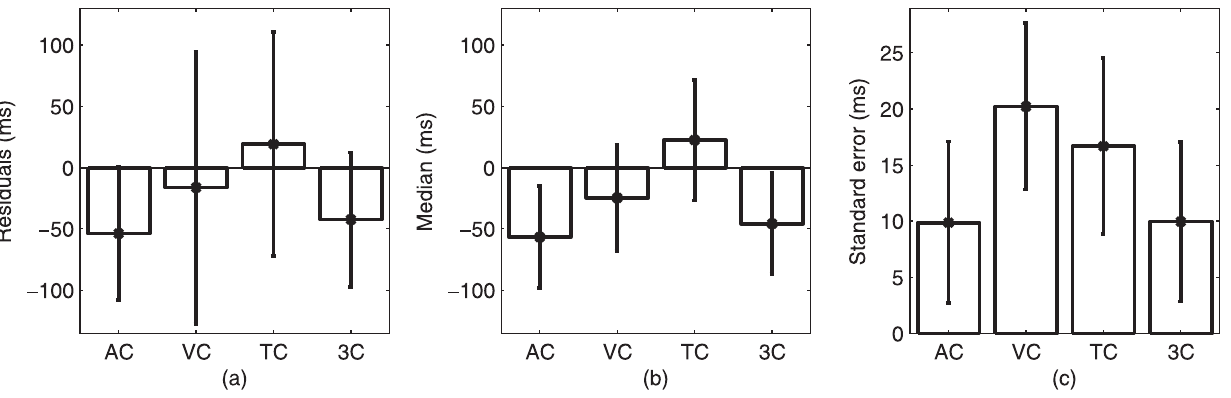
Figure 3. Examination of stepping response, i.e., how well each cue was followed in terms of mean residuals for the four cued conditions (AC = auditory cue; VC = visual cue; TC = tactile cue; 3C = three cues). (a) mean residuals (ms); (b) median residuals (ms); and (c) standard error (ms). A negative value means that participants walked ahead of the metronomic beat. Error bars denote standard deviation in each case.